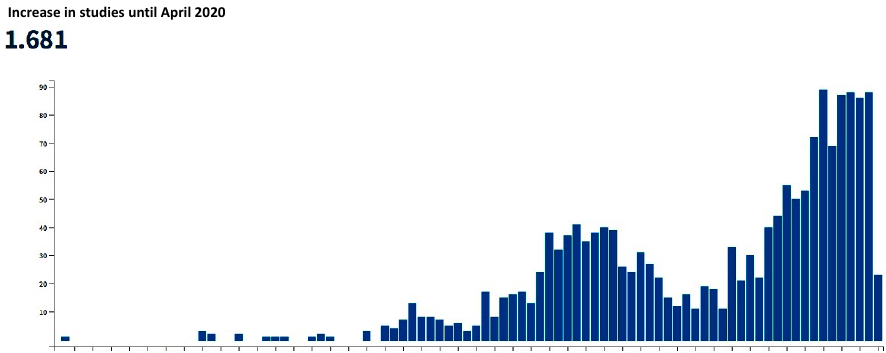
Figure 2. Studies according to the U.S. National Library of Medicine database, using “root canals” and “anatomy morphology” as the keywords. Source: U.S. National Library of Medicine. US National